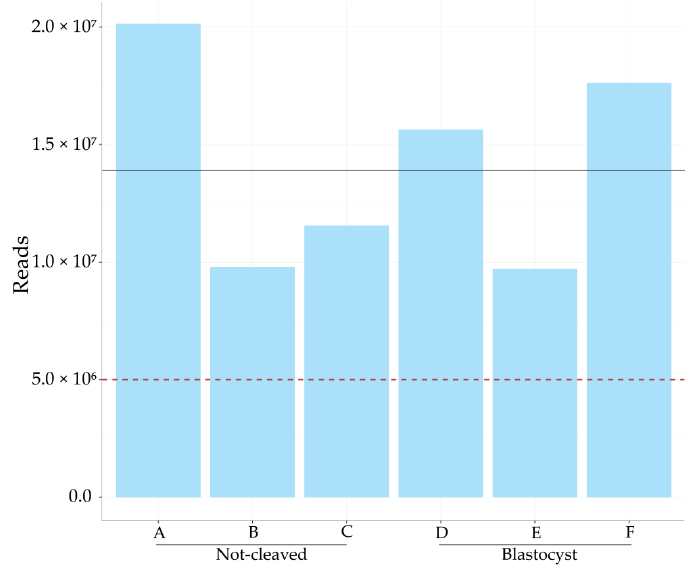
Figure 1. Total number of micro RNA (miRNA) reads in each sample. The total number of miRNA sized reads for each sample of cumulus cells pooled from 10 to 16 bovine cumulus–oocyte complexes; on average, 14 million reads were obtained per sample, as indicated by the black line. The red dotted line marks five million reads, the amount considered sufficient for meaningful analysis. A, B, C = cumulus pieces surrounding oocytes that failed to cleave after exposure to sperm; D, E, F = cumulus pieces surrounding oocytes that developed into a blastocyst after fertilization. miRNAs were identified according to entries in miRBase Release 20. A mean of 332 miRNA species had more than 10 reads (Figure 2, blue bars), while 240 miRNA species had more than 50 reads per sample (Figure 2, red bars). The majority of the miRNAs were present in all samples; of the miRNA species identified, 276 with more than 10 counts and 205 with more than 50 counts were present in all samples. No repeatable differences in the numbers of miRNAs identified were present between the two types of sample (Figure 2).